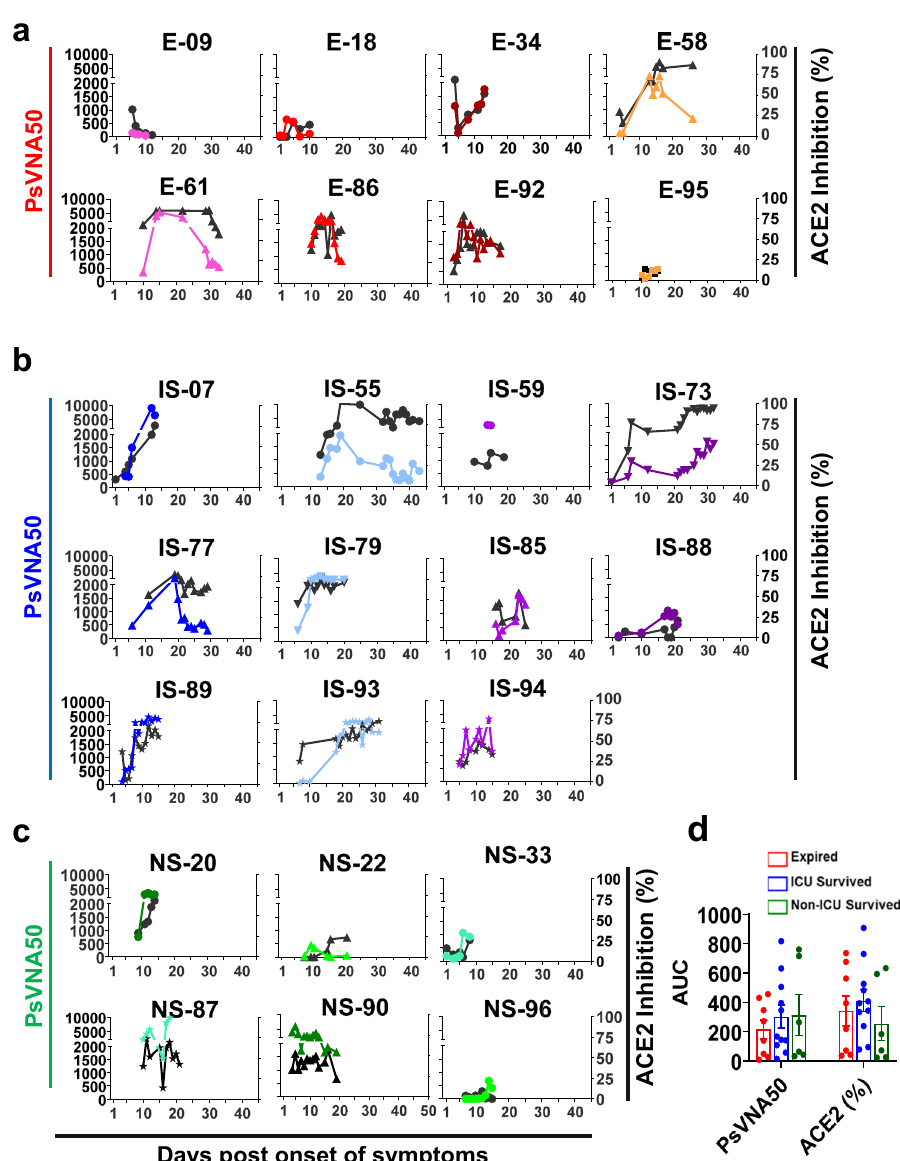
Fig. 2 Neutralizing antibody titers and hACE2 receptor inhibition activity of COVID-19 patients ’ plasma during hospitalization. SARS-CoV-2 neutralizing antibody titers (PsVNA50) in plasma at various time-points as determined by pseudovirion neutralization titer 50 (PsVNA50) in Vero E6 cells are shown in colored curves, and the percentage of ACE2 inhibition values at different days post-onset of symptoms are shown in black curves. a “ Expired ” patients ( n = 8); b “ ICU-survived ” patients ( n = 11); and c “ non-ICU survived ” ( n = 6) patients. Expired patients (patient number ’ s starting with e ); ICU- survived patients (patient number ’ s starting with IS); and non-ICU survived patients (patient number ’ s starting with NS). Virus neutralization PsVNA50s titers were calculated with GraphPad prism version 8. Percent inhibition of hACE2 binding to RBD in presence of 1:100 dilution of COVID-19 plasma was measured by ELISA. The neutralization and ACE2-inhibition experiments were performed twice independently with similar results. d Area under the curve (AUC) was determined for the PsVNA50 or the percent ACE2 inhibition from day 1 through day 20 of the three COVID-19 patient groups to control for the window of samples collected. Bar chart shows datapoints for each individual and presented as mean values±SEM. The statistical signi fi cances between the groups were determined by non-parametric (Kruskal – Wallis) statistical test using Dunn ’ s multiple comparisons analysis in GraphPad prism for the area under curve (AUC values) between “ expired ” patients (red; n = 8 biologically independent individuals), “ ICU-survived ” patients (blue; n = 11 biologically independent individuals), and “ non-ICU survived ” patients (green; n = 6 biologically independent individuals) did not identify any statistical signi fi cance ( p